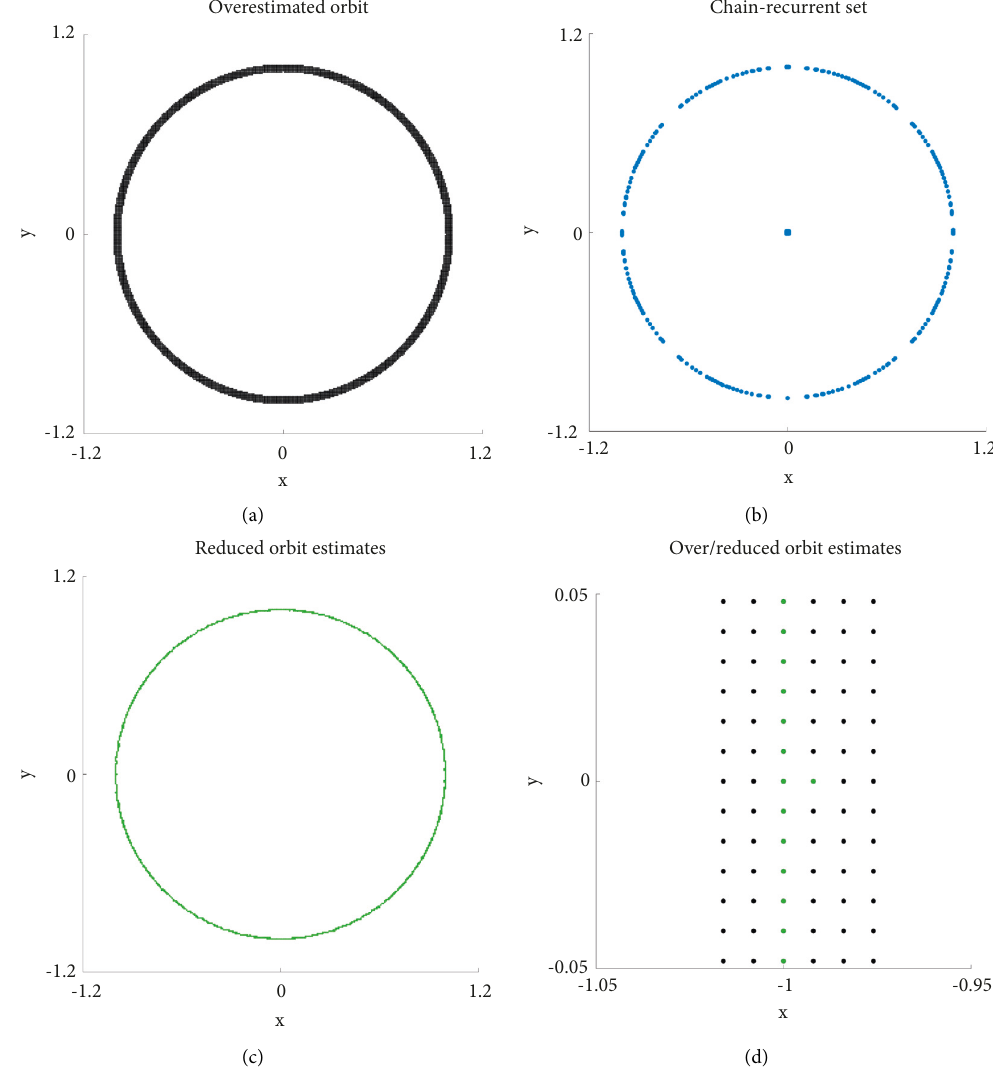
C v, 14 . (b) The underestimation of the chain recurrent set v, 0 . 8 .